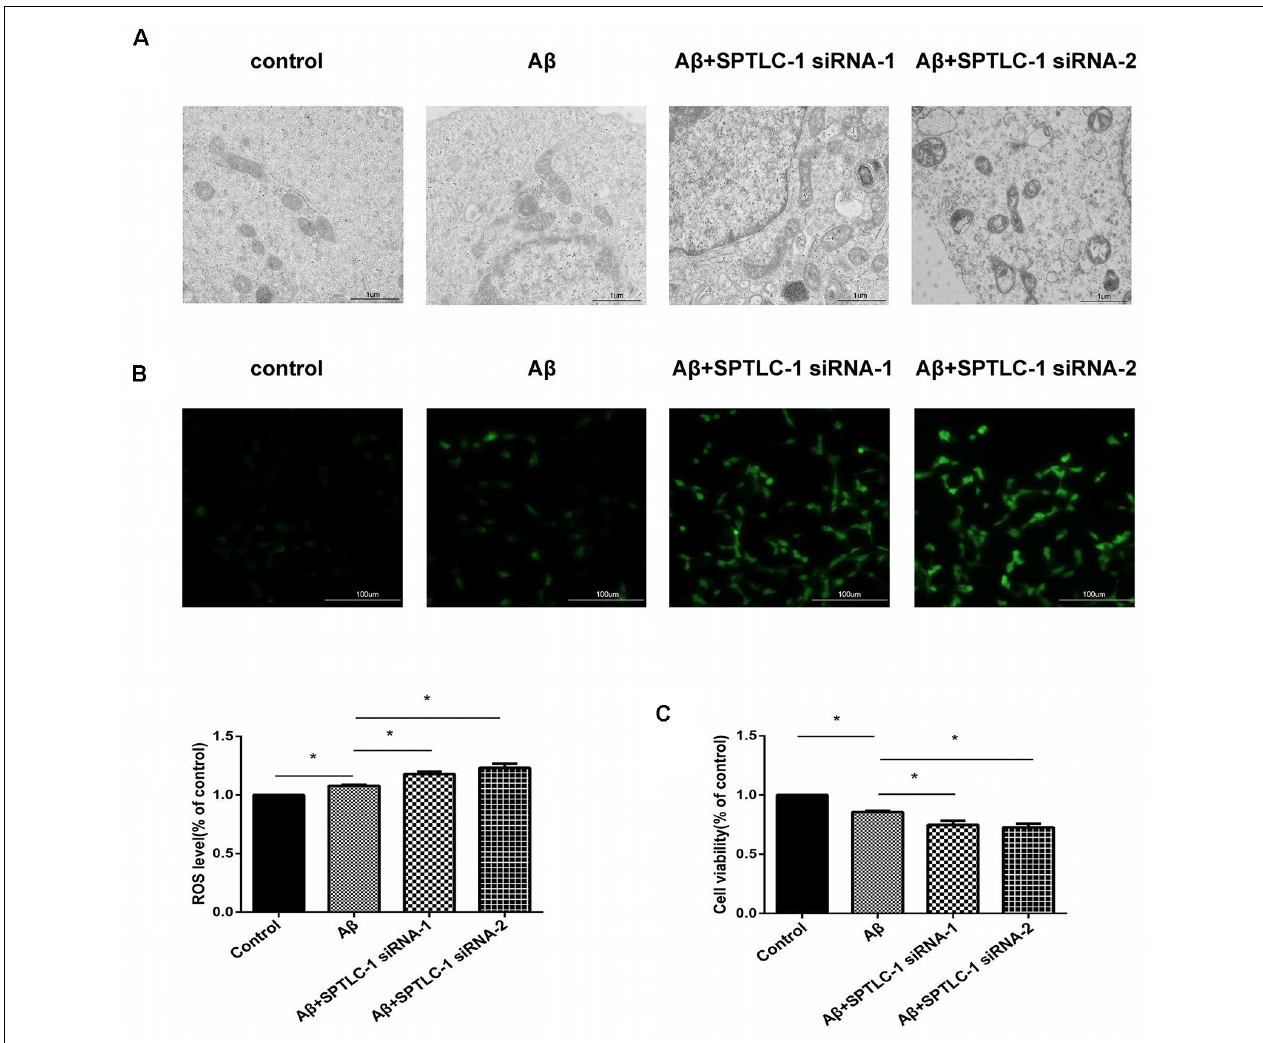
FIGURE 5 | Inhibition of the sphingolipid biosynthesis pathway by SPTLC-1 siRNAs changes the mitochondrial structure, increases the intracellular ROS level and aggravates the cytotoxic effect of A β 25–35 in SHSY5Y cells. After transfected with SPTLC-1 siRNAs for 48 h and 20 µ M A β 25–35 for 1 h, the mitochondrial structure of SHSY5Y cells was observed by a electron microscope (A) , the intracellular ROS level was measured by DCFH (B) , viability of the cells was examined by CCK8 assay (C) . The data are mean ± SEM ( n = 3, ∗ p < 0.05).